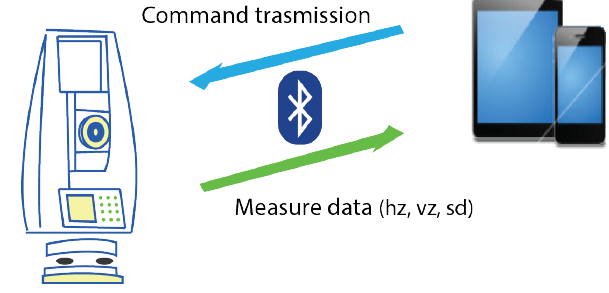
Figure 2: Portable device total station